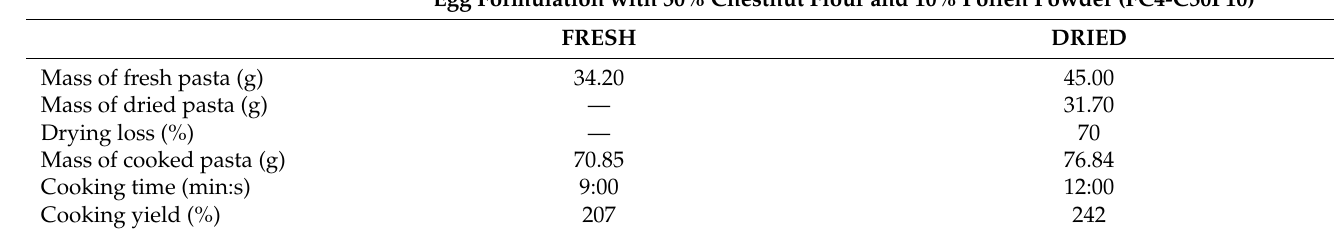
Table 7. Pasta with egg and 50% chestnut flour and 10% pollen